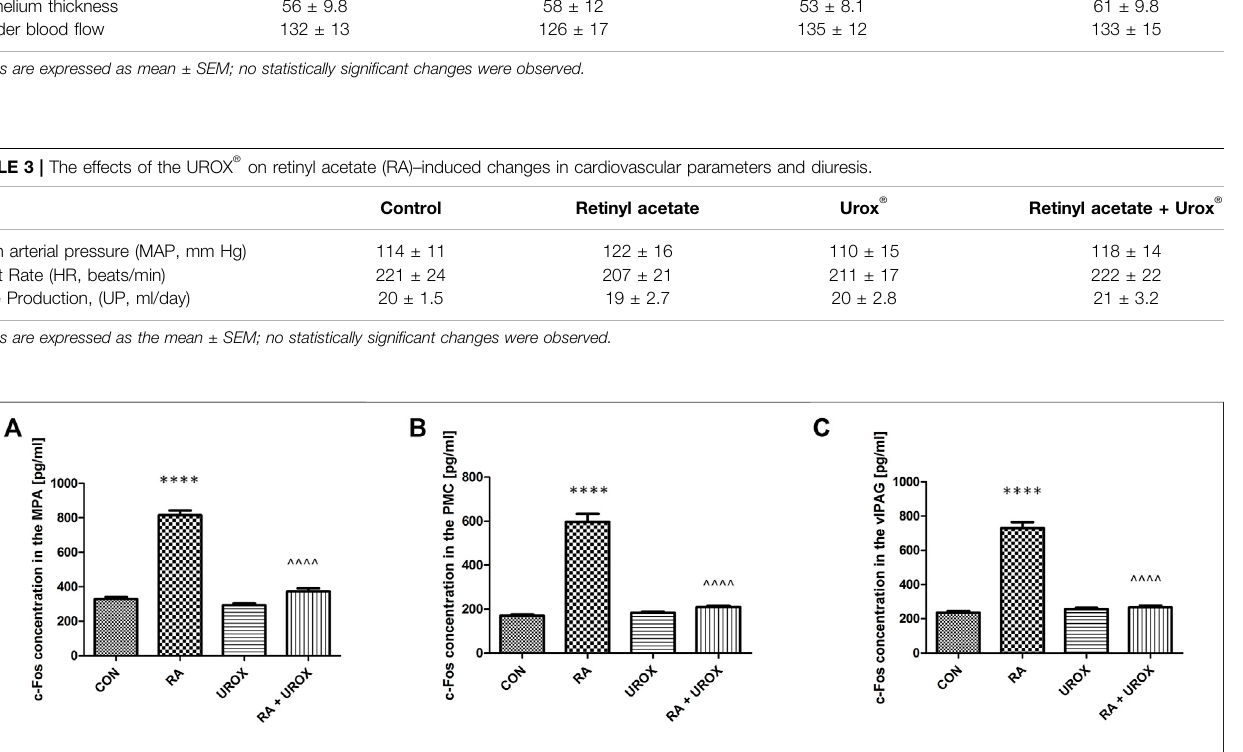
FIGURE 1 | The effects of Urox ® (840 mg p.o., once daily for 14 consecutive days) on c-Fos expressions in the neuronal voiding centers: (A) medial preoptic nucleus (MPA), (B) pontine micturition center (PMC), and (C) ventrolateral periaqueductal gray (vlPAG) after the induction of overactive bladder with retinyl acetate (RA). Concentration of c-Fos in each group (pg/ml): control group (CON), RA group (RA), Urox-only group (UROX) and RA group treated with UROX (RA + UROX). Values are expressed as mean ± SEM.**** or ^^^^ p < 0.0001; *signi fi cantly different from the control group; ^ signi fi cantly different from the RA group. One-way ANOVA: for MPA: F (3.56) = 163, p < 0.0001; for PMC: F (3.56) = 115, p < 0.0001; for vlPAG: F (3.56) = 155, p <